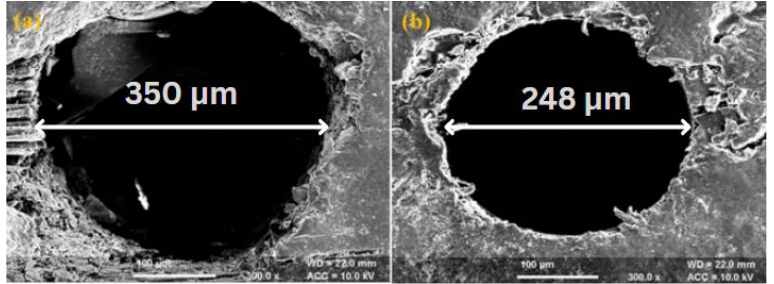
Figure 5. SEM of drilled micro-holes using ( a ) Taguchi’s methodology ( b ) TOPSIS Method.